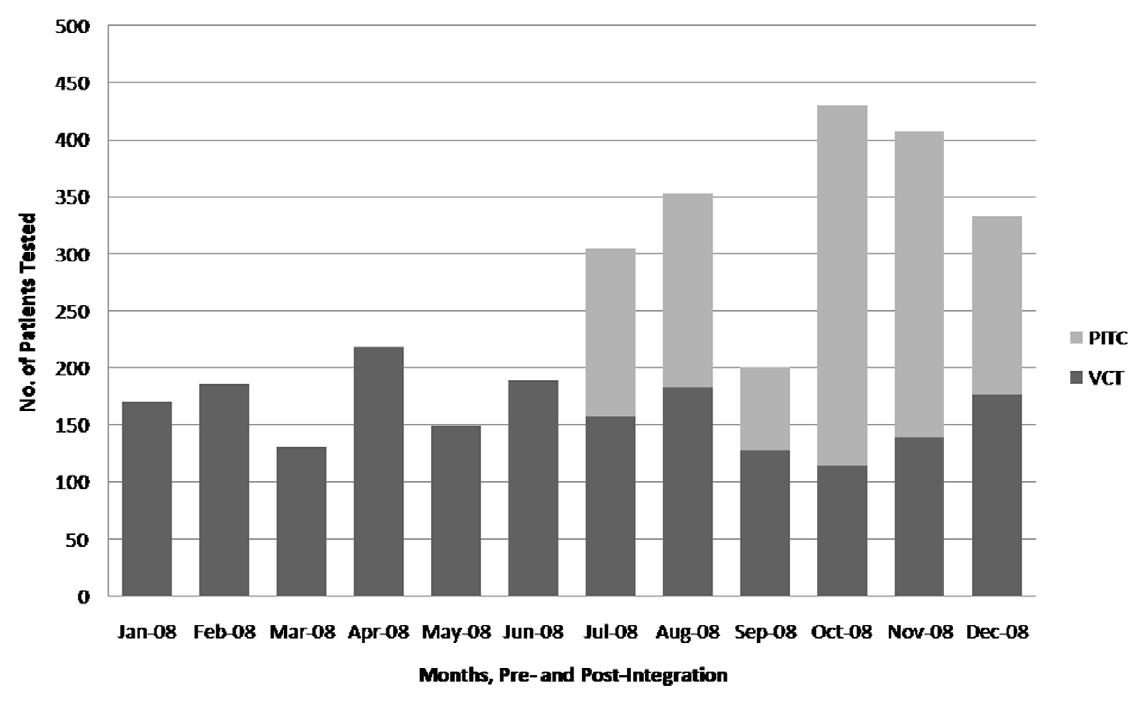
Figure 2. Clinic 1 testing pre- and post-integration.